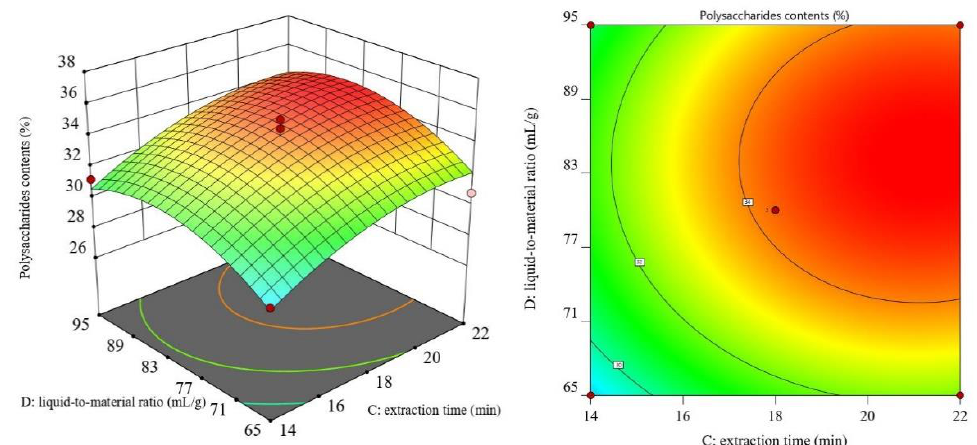
Figure 8. Effect of the interaction of time and liquid-to-material ratio on polysaccharide yield. (C is